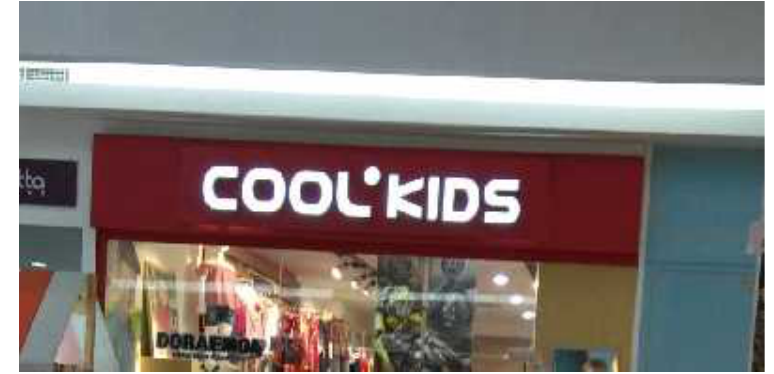
Figure 11. Shop Name Using